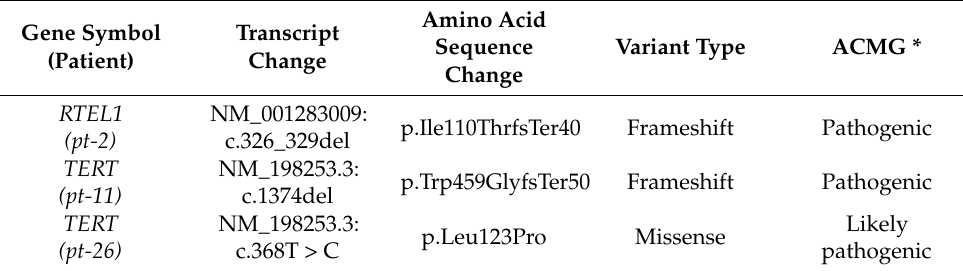
Table 2. Pathogenic variants found in our IPF